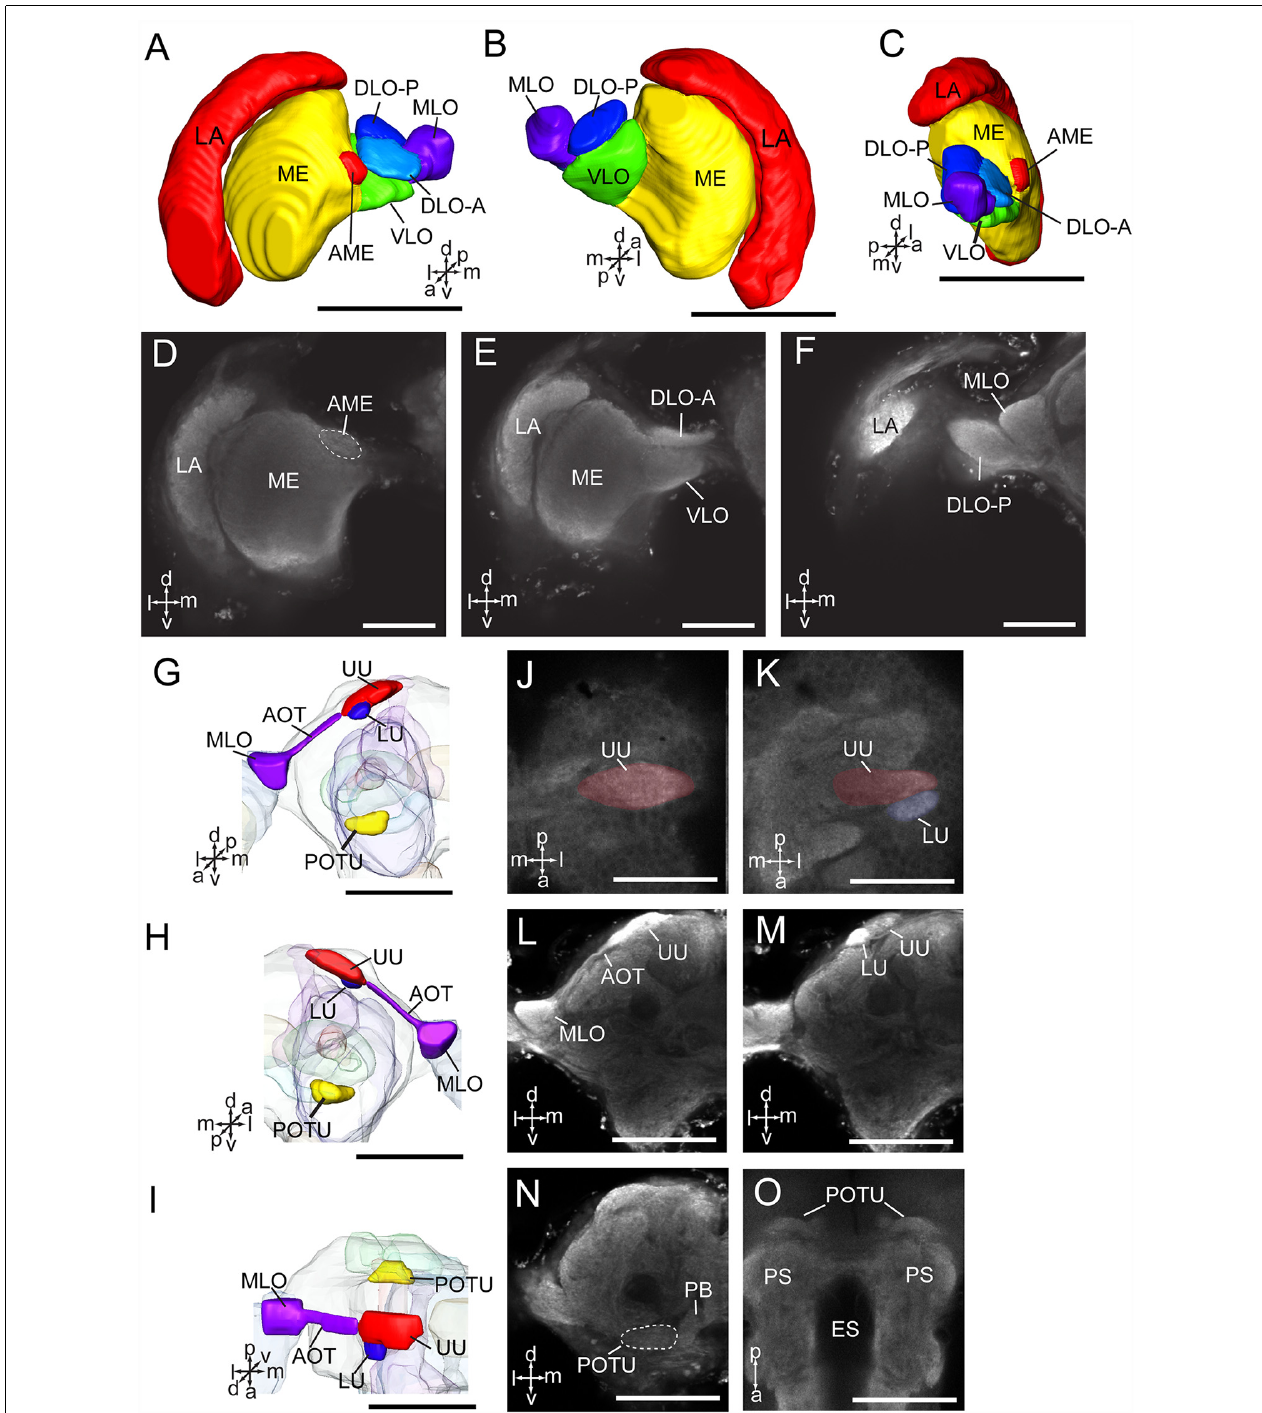
FIGURE 3 | Three-dimensional reconstructions and confocal images of Apolygus lucorum optic lobe and optic tubercles. (A) Three-dimensional reconstructions of optic lobe in frontal view. (B) Posterior view. (C) Sagittal view. (D–F) Confocal images of optic lobe at different depths. (G) Three-dimensional reconstructions of anterior and posterior optic tubercles in frontal view. (H) Posterior view. (I) Dorsal view. (J,K) Confocal images of AOTU in dorsal view. (L,M) Confocal images of AOTU in frontal view. (N) A confocal image of posterior optic tubercle in frontal view. (O) A confocal image of posterior optic tubercle in dorsal view. AME, accessory medulla; AOT, anterior optic tract; DLO-A, anterior part of dorsal lobula; DLO-P, posterior part of dorsal lobula; ES, esophagus; LA, lamina; LU, lower unit of anterior optic tubercle; ME, medulla; MLO, medial lobula; PB, protocerebral bridge; POTU, posterior optic tubercle; PS, posterior slope; UU, upper unit of anterior optic tubercle; VLO, ventral lobula. Directions: a, anterior; d, dorsal; l, lateral; m, medial; p, posterior; v, ventral. Scale bars: 100 µ m in (A–C,G–I,L–O) , 50 µ m in (D–F,J,K) .